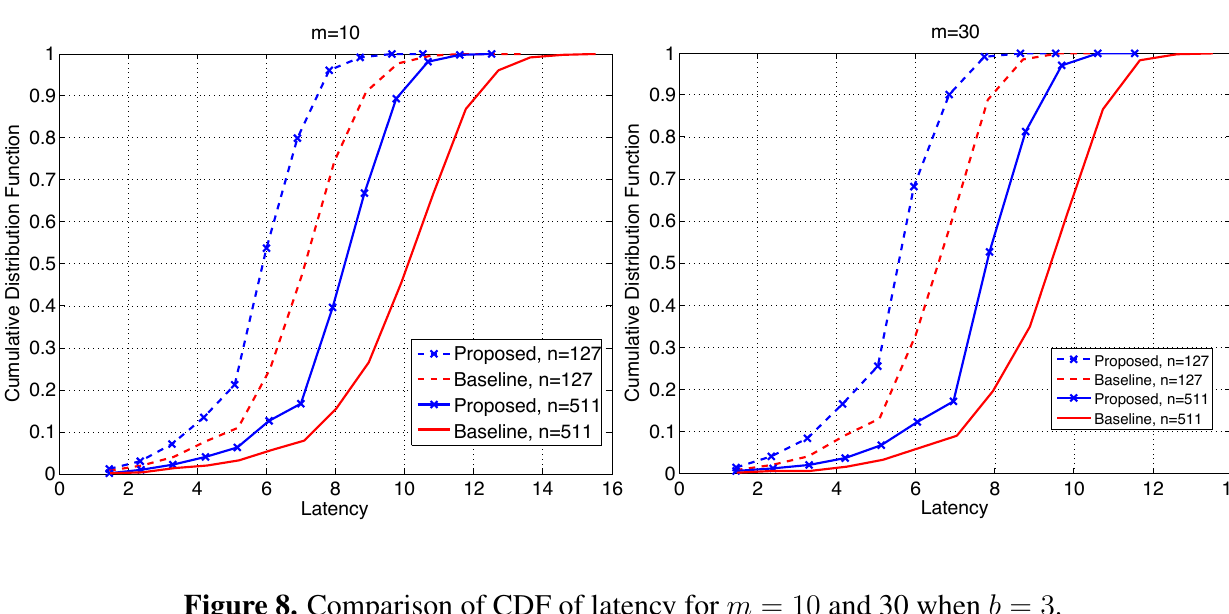
Figure 7. Comparison of CDF of latency for m = 10 and 30 when b = 1 .